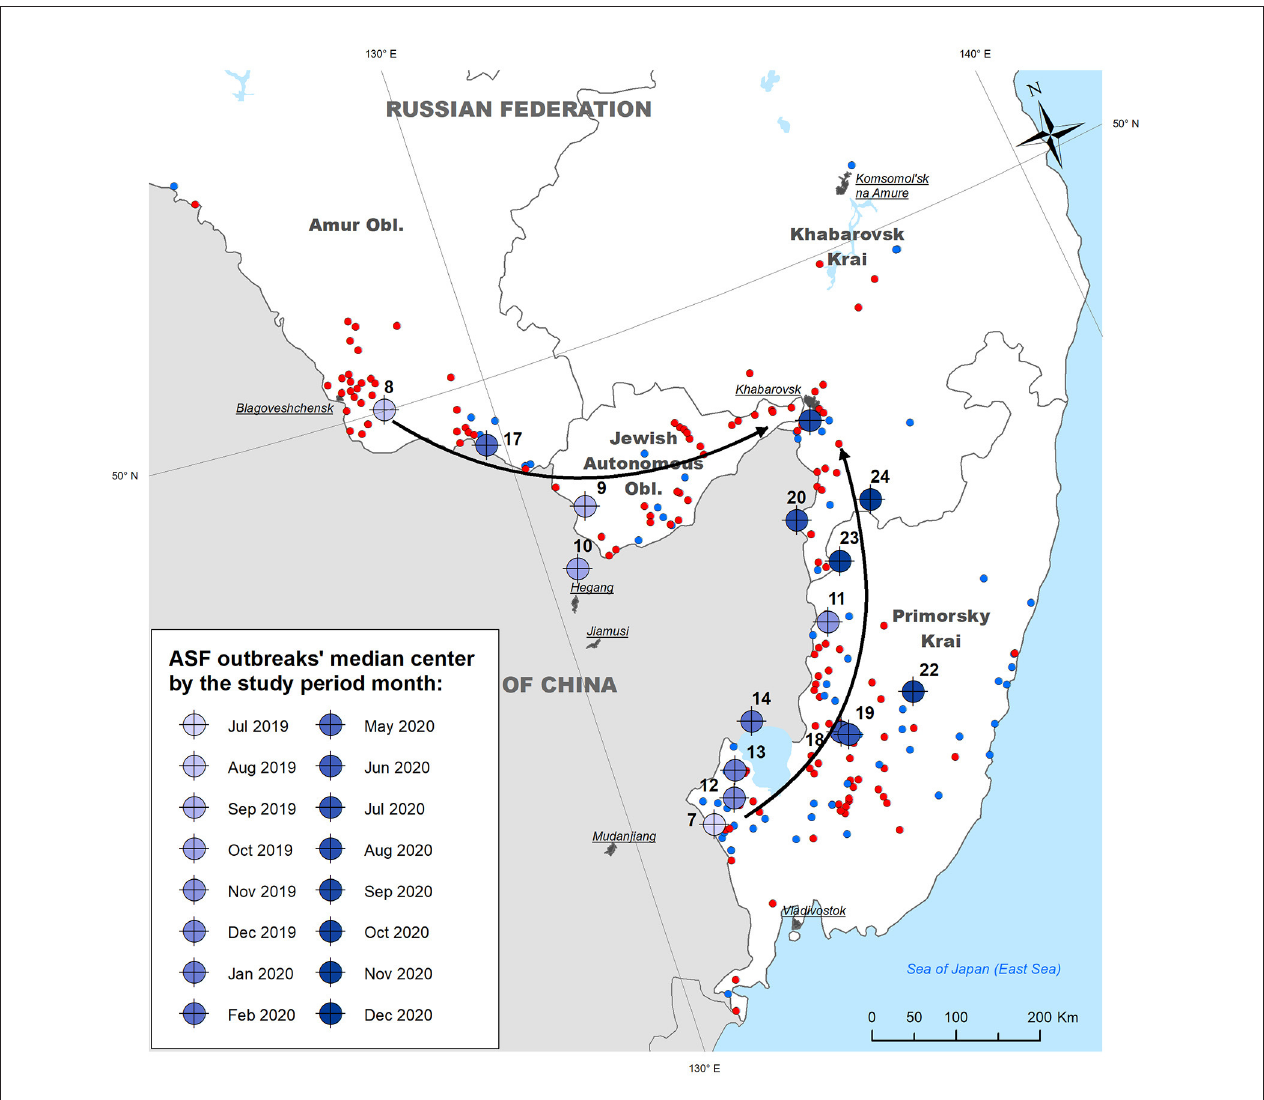
FIGURE 3 | Median centers of ASF outbreaks in the Far East region of Russia by month from July 2019 to December 2020. Arrows indicate the apparent direction of the epidemic movement.